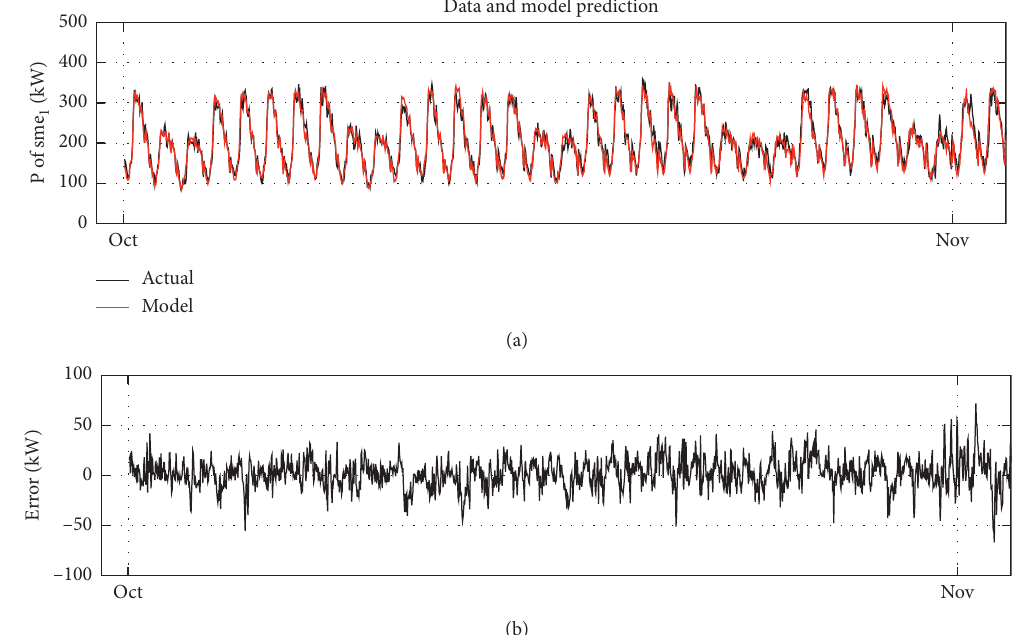
Figure 7: Test set behavior related to sme : (a) the red curve represents the predicted real power values and black curve represents the actual 1 one; (b) the differences between predicted and actual load